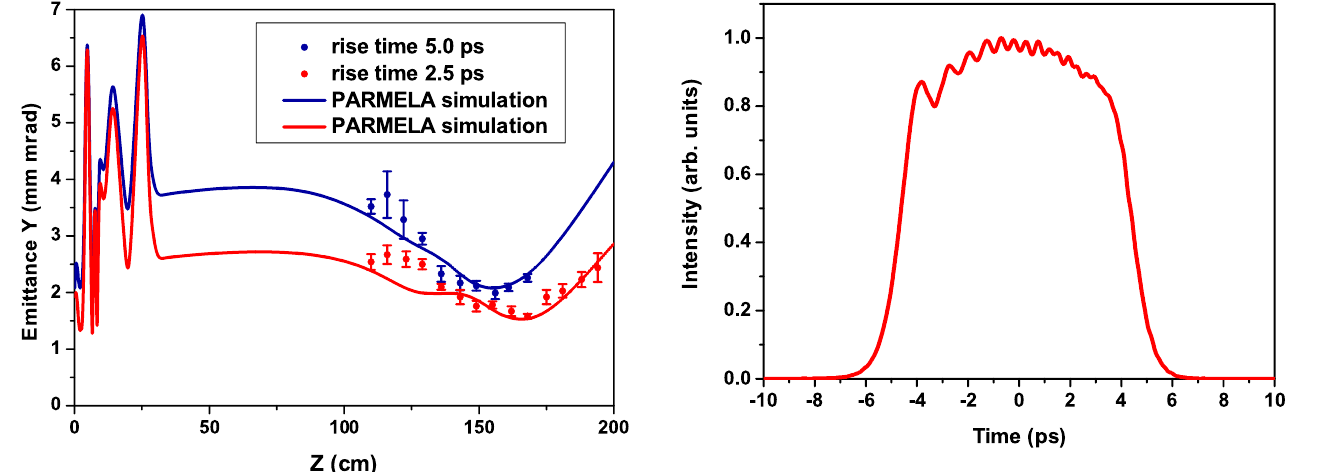
FIG. 15. (Color) Vertical emittance evolution for the beams with the longitudinal profiles of Fig. 14 and parameters of Table III.